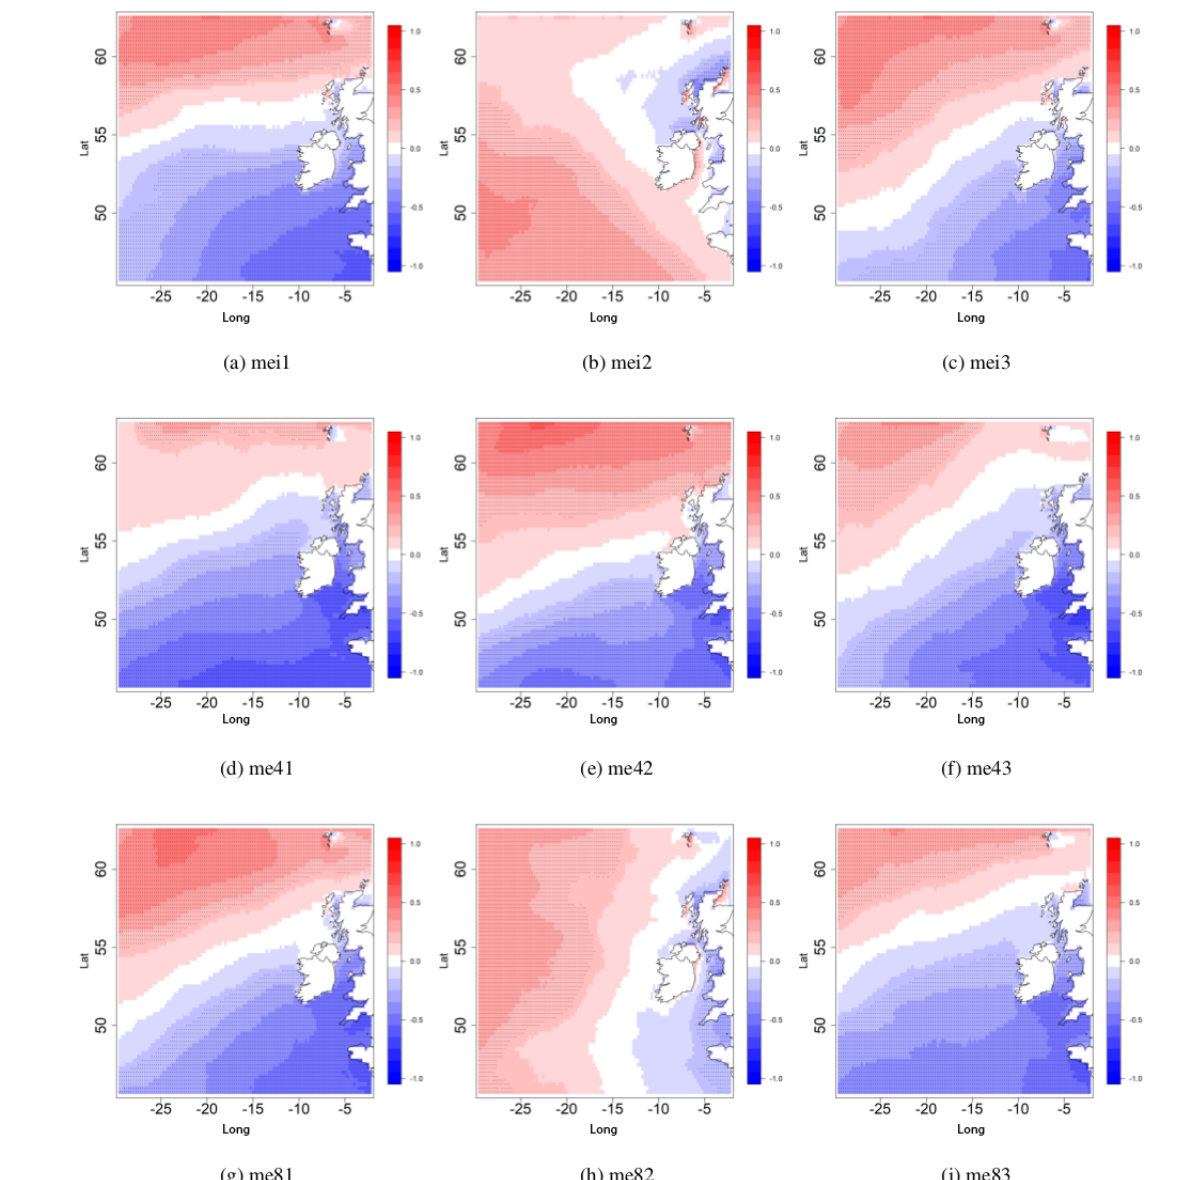
Figure 4. The Spearman correlation coefficient between the SCAND index and the 95th percentile of H s for DJFM. (a–c) historical period (1980–2009) 3 × ensemble members; (d–f) future period 2070–2099 under RCP4.5 and similarly (g–h) is for 2070–2099 under RCP8.5. Correlations statistically significant at the α < 0 . 05 level are